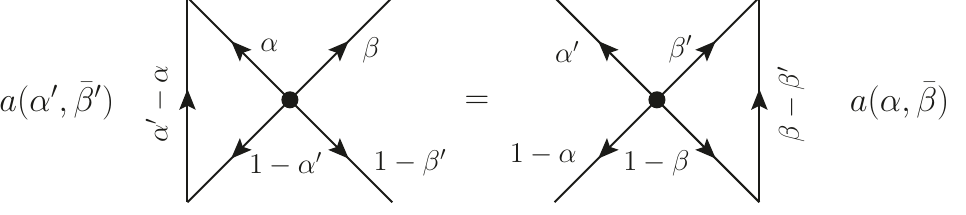
Figure 13 . The cross relation, (cid:11) + (cid:12) = (cid:11) 0 + (cid:12) 0